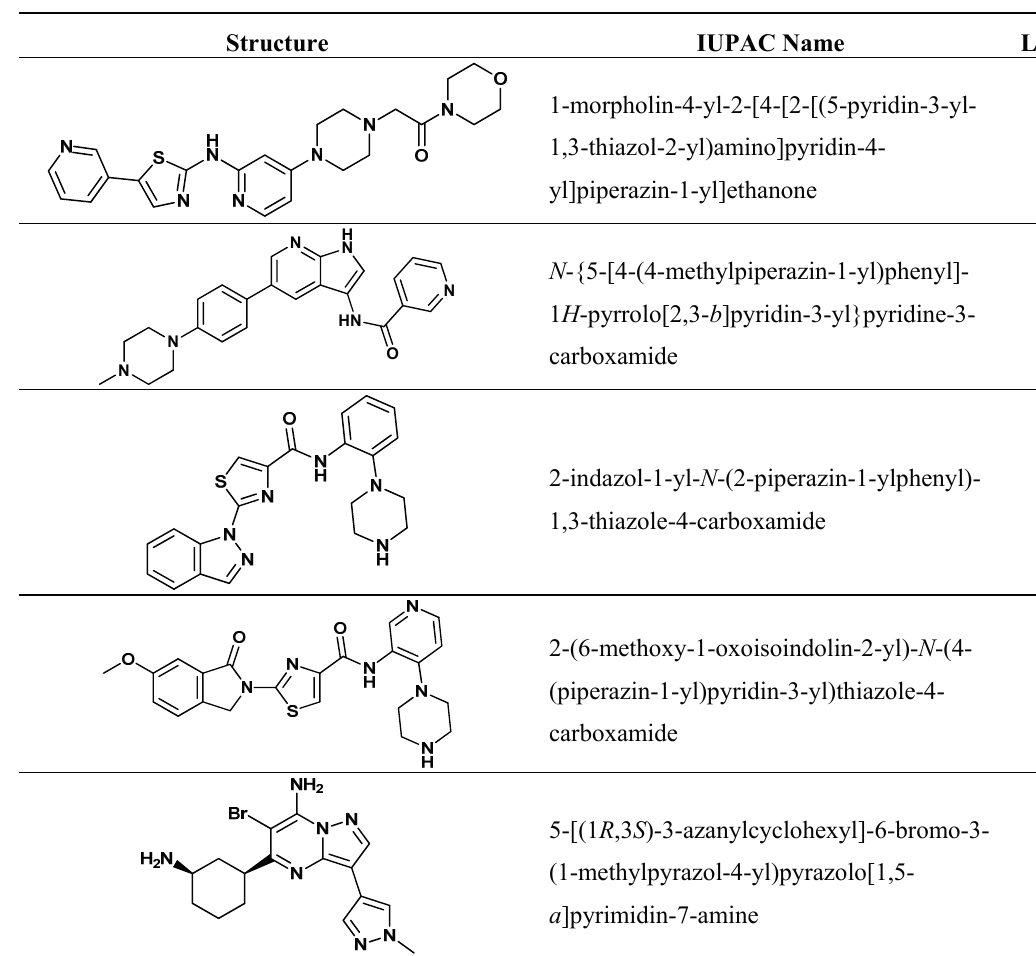
Table 4. List of ligand structures considered in this